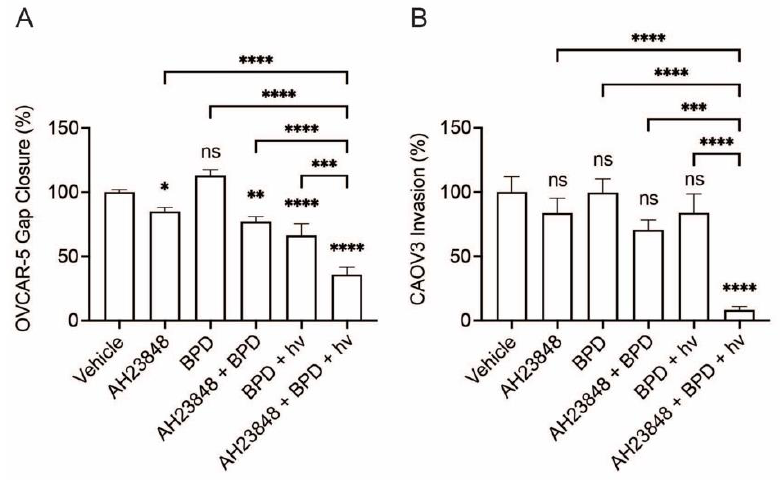
Figure 1. Anti-migratory effects of BPD-based PDP, EP4 inhibitor (AH23848), and their combination were evaluated in ( A ) a gap closure assay using OVCAR-5 cells and ( B ) the transwell invasion assays using CAOV3 cells. All data are normalized to the vehicle (DMSO) control, and statistical analysis was performed using a one-way ANOVA and post hoc Tukey’s test. Error bars represent the standard error of the mean. * p ≤ 0.05; ** p ≤ 0.01; *** p ≤ 0.001; **** p ≤ 0.0001; ns: nonsignificant.